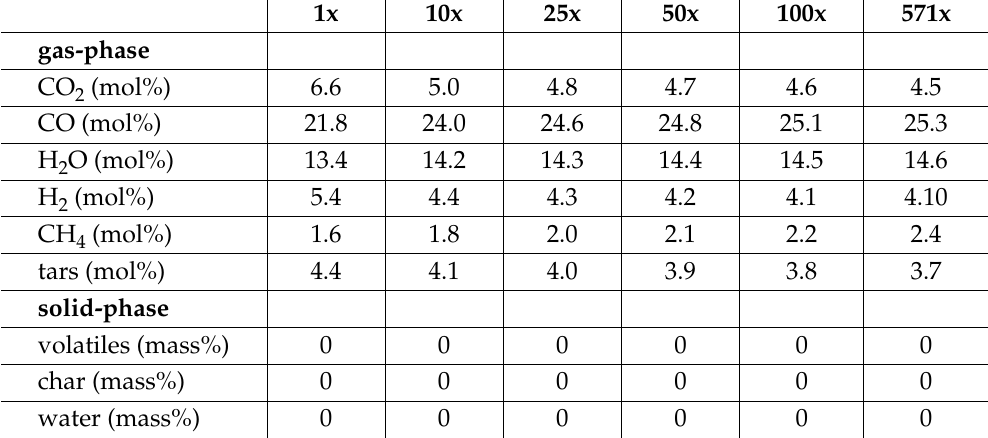
Table 9. Producer-gas composition for different gasifier